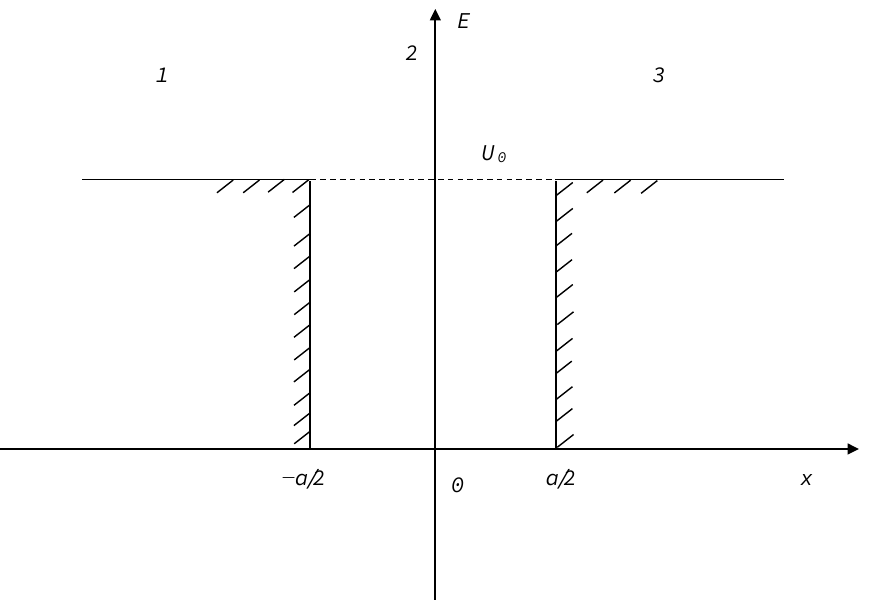
Figure 3. One-dimensional potential pit with finite walls. The simplest option.